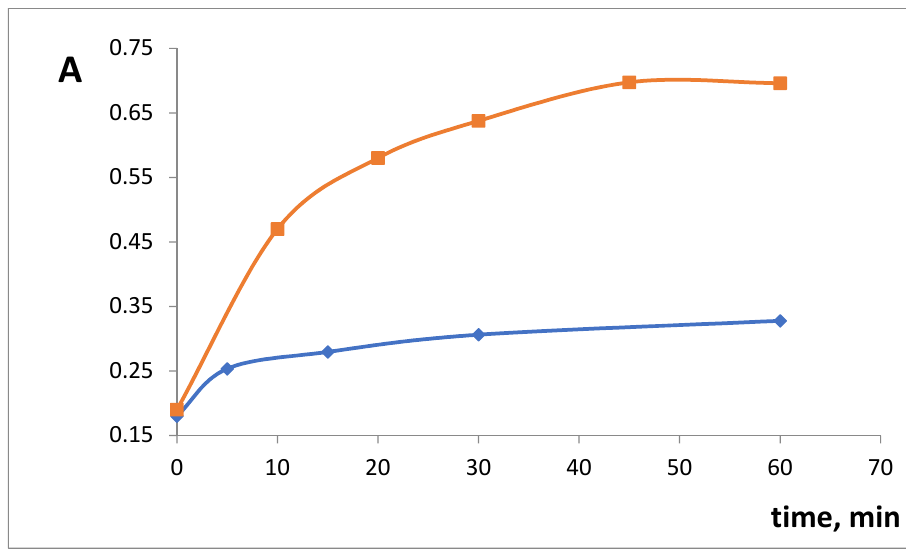
Figure 5. The kinetics of the interaction of silica xerogels doped with iron(III) absorbance after the interaction with 3 × 10 − 4 M salicylhydroxamic acid (SHA). λ 450 nm, m/V = 0.10 g/5.0 mL, pH 3.3. blue—SiFe1, red—SiFe10.